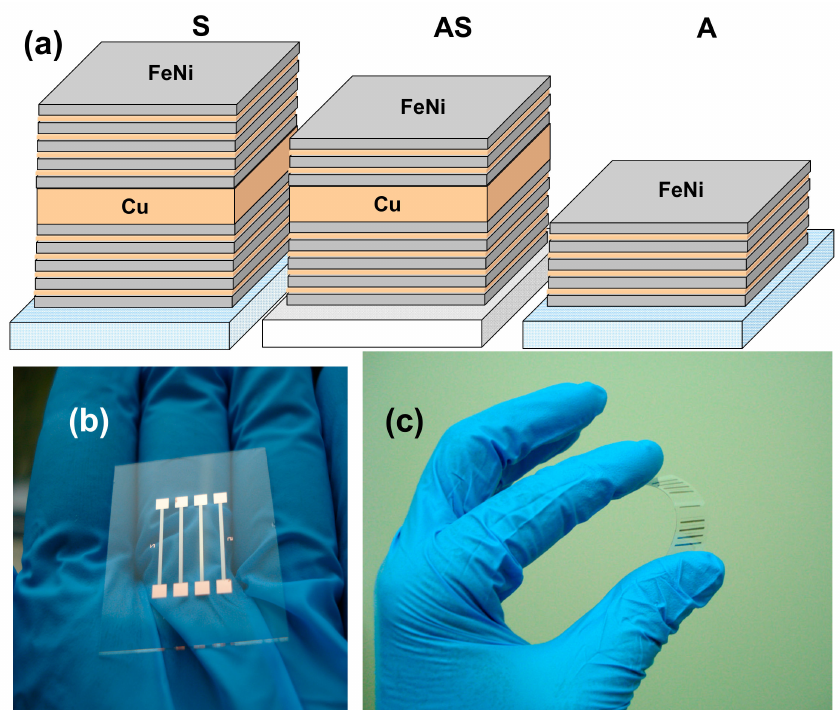
Figure 2. Schematic description of the GMI multilayered structures ( a ). General view of GMI-sensitive elements deposited onto glass ( b ) and flexible polymer ( c )